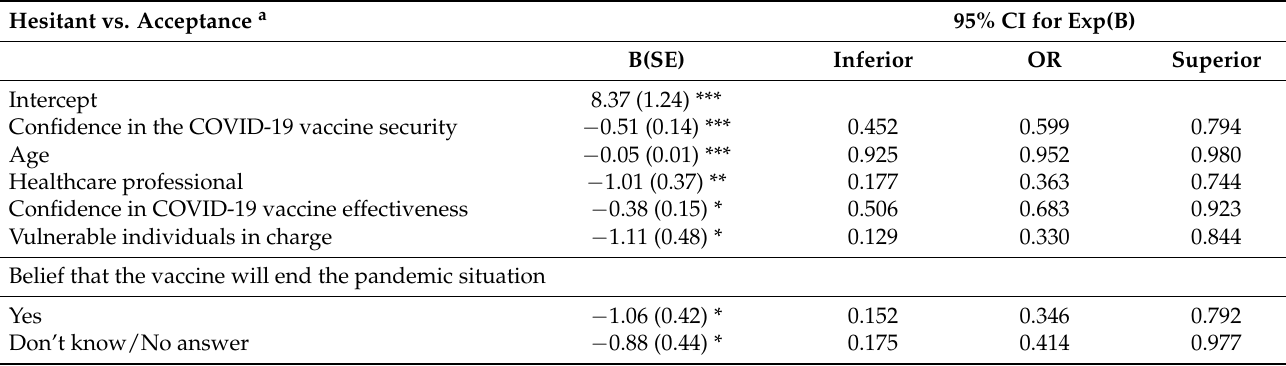
Table 4. Binary logistic regression model ( N =